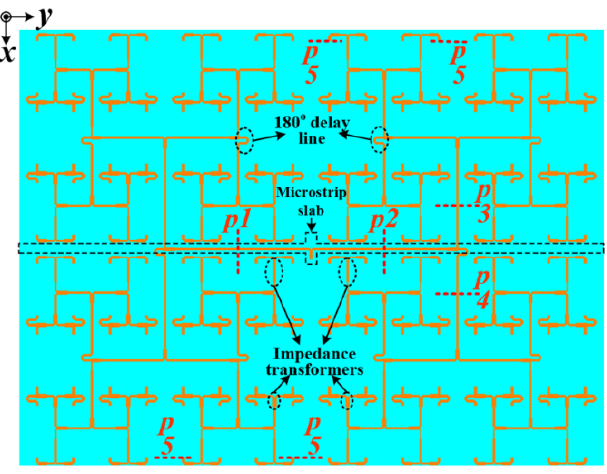
Figure 6. Configuration of the developed feeding network.